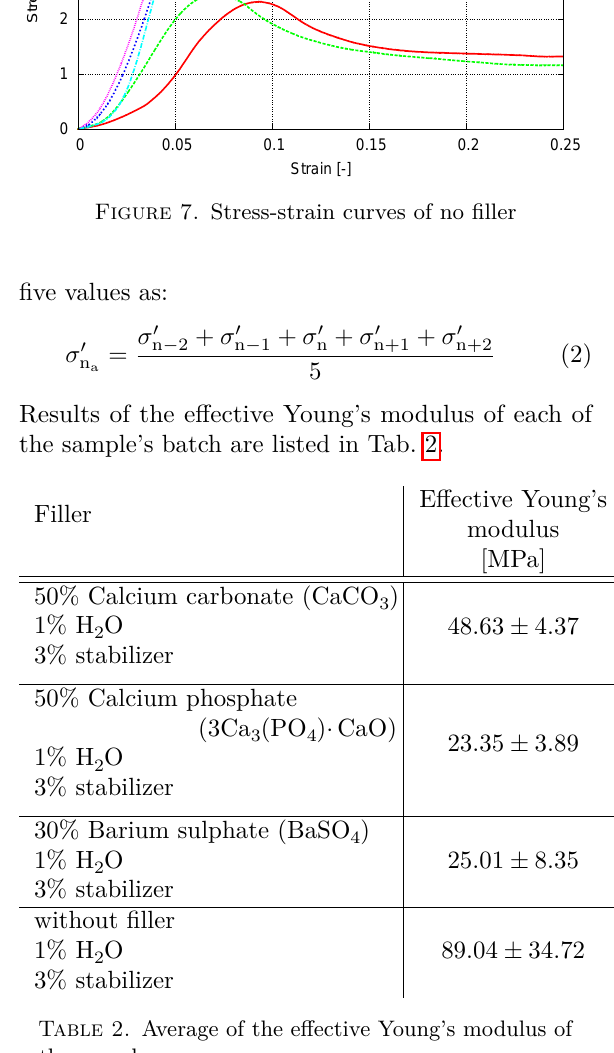
evaluation, Chris- Y